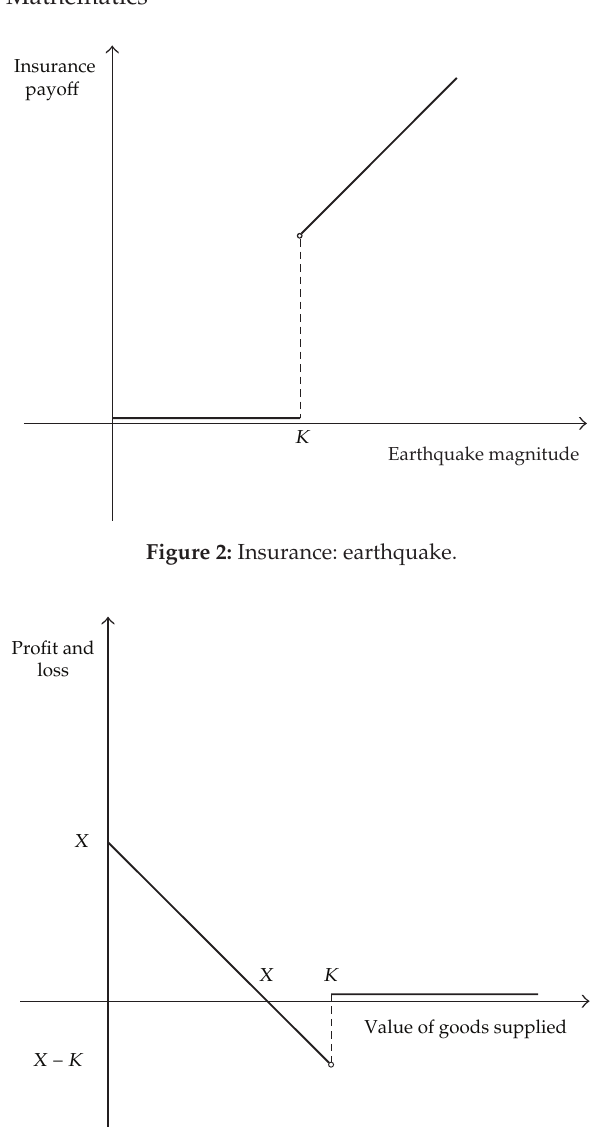
Figure 3: Real option: request for